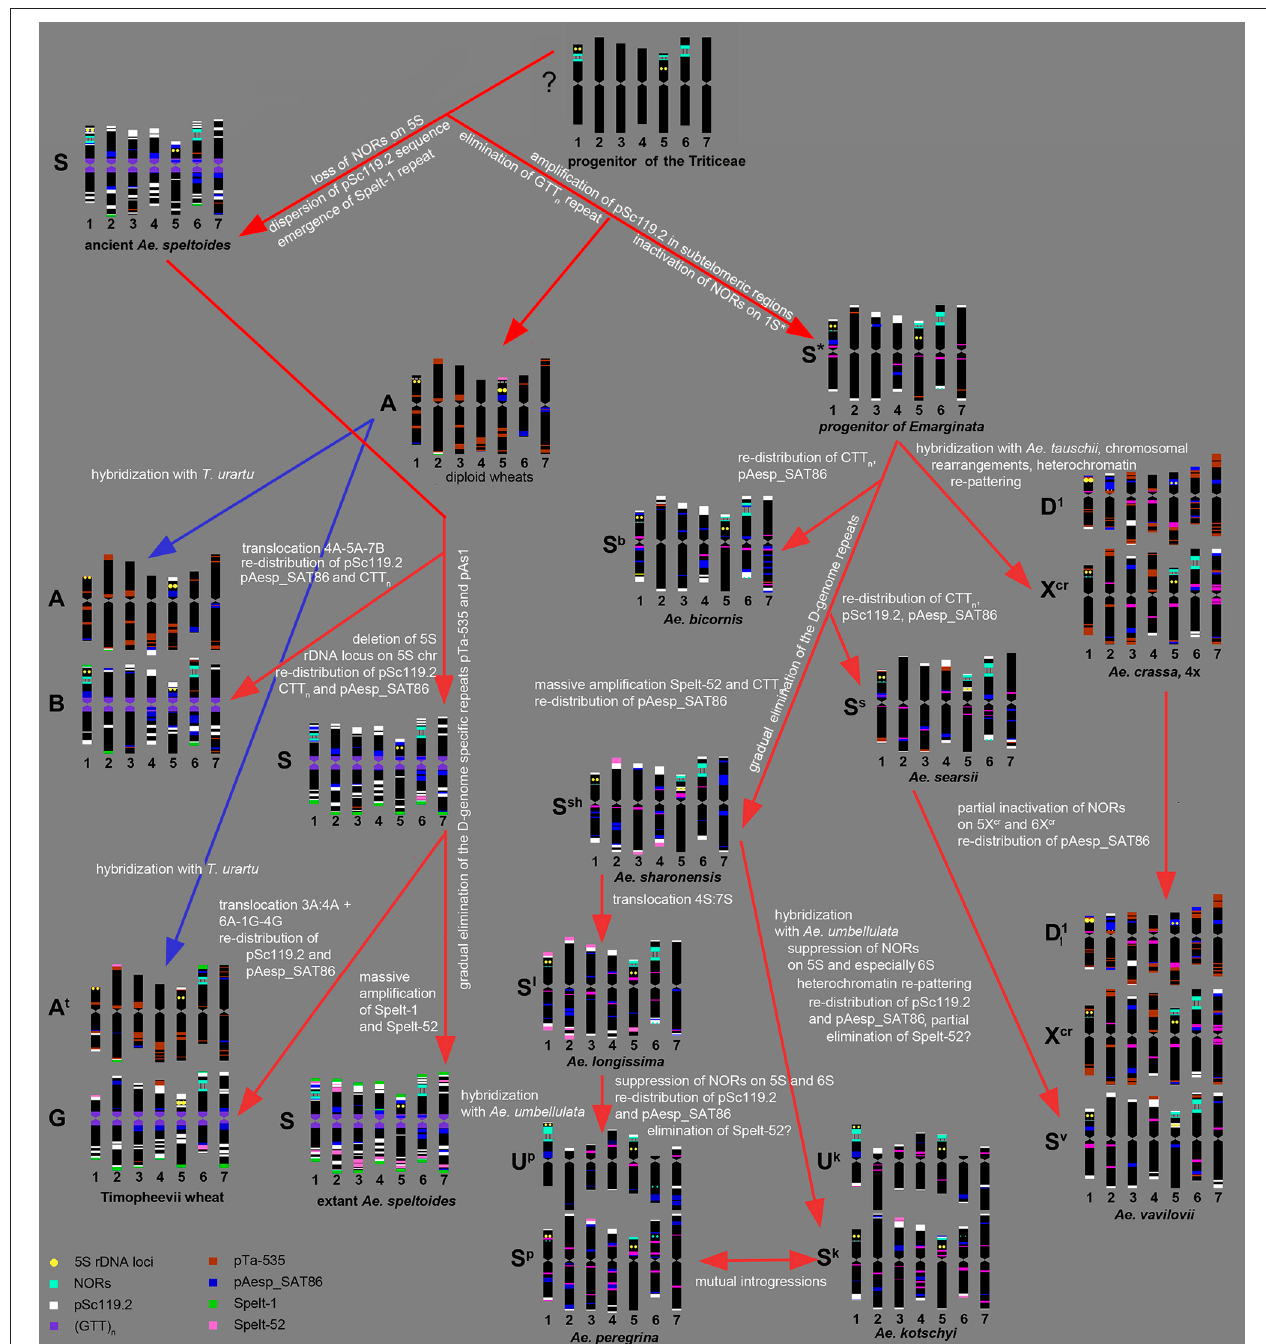
FIGURE 9 | Hypothetic scheme of the S-genome evolution deduced from the results of molecular-cytogenetic analysis.